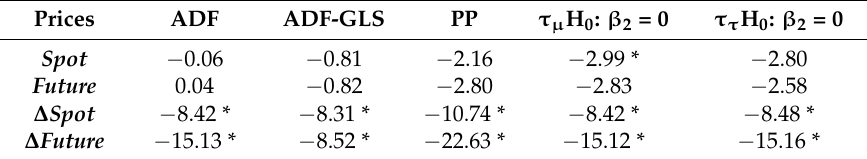
Table 2. Stationarity tests.